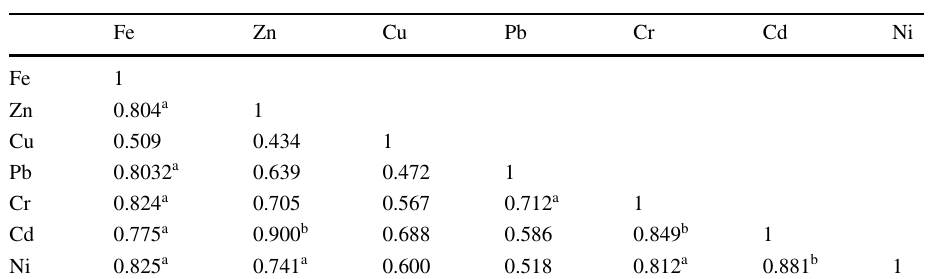
a Correlation is significant at the 0.05 level (two-tailed) b Correlation is significant at the 0.01 level